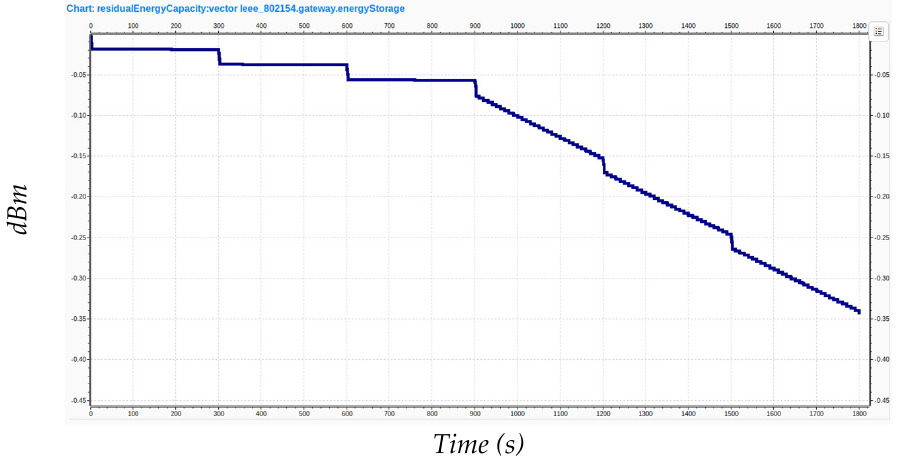
Figure 8. Residual energy of the gateway—an example from the OMNET++ experiments.